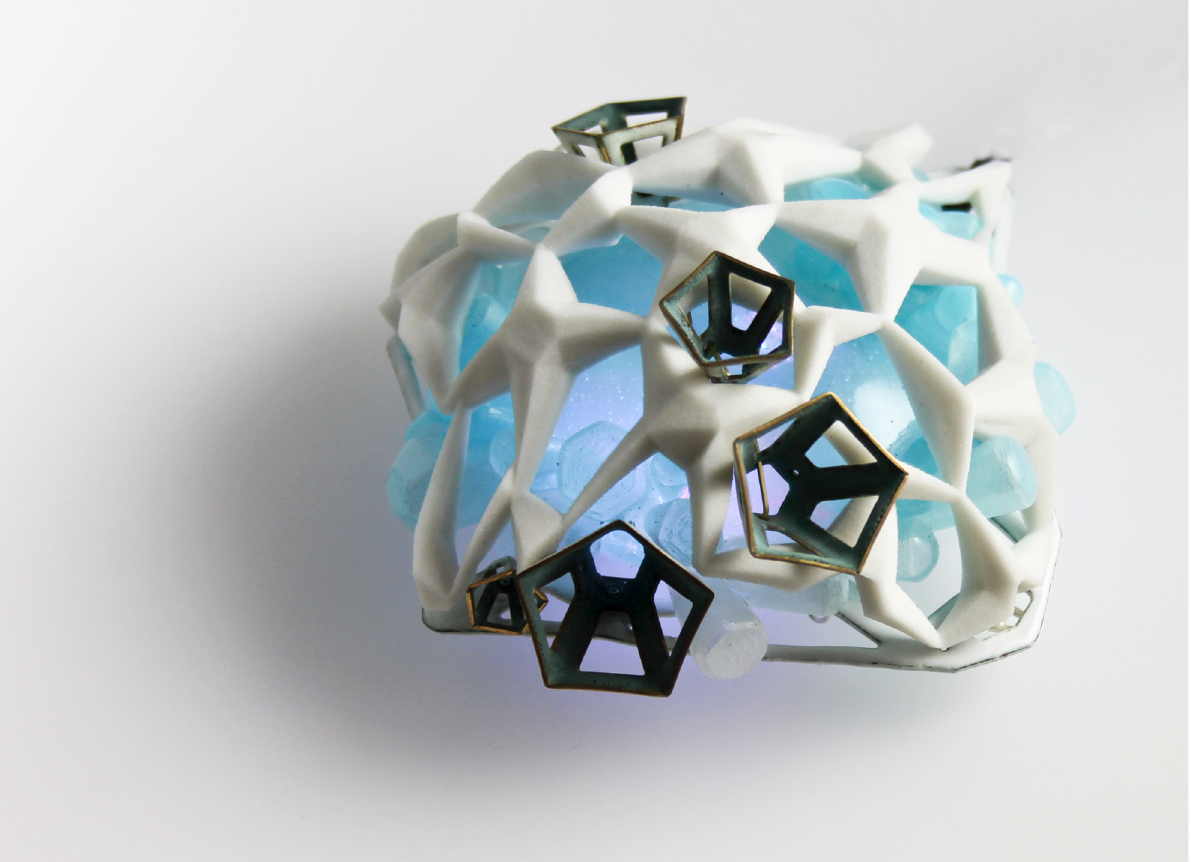
Figure 11 | Geotronic Brooch, Katharina Vones (2013).